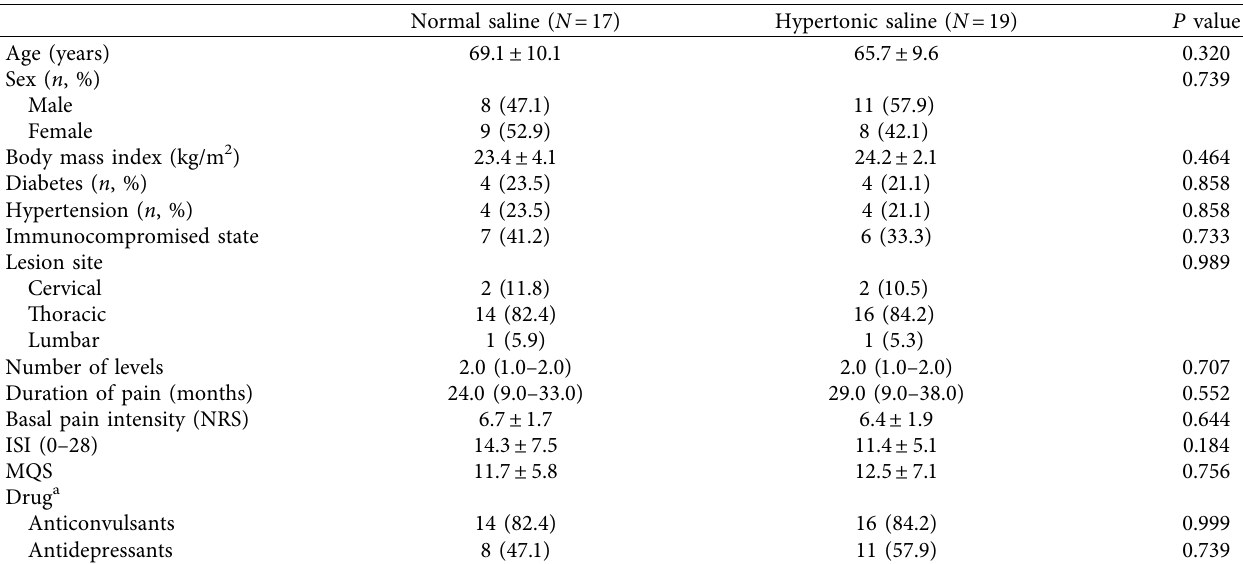
Figure 1: CONSORT (Consolidated Standards of Reporting Trials) fow diagram of participants in this trial. Table 1: Baseline characteristics of the study